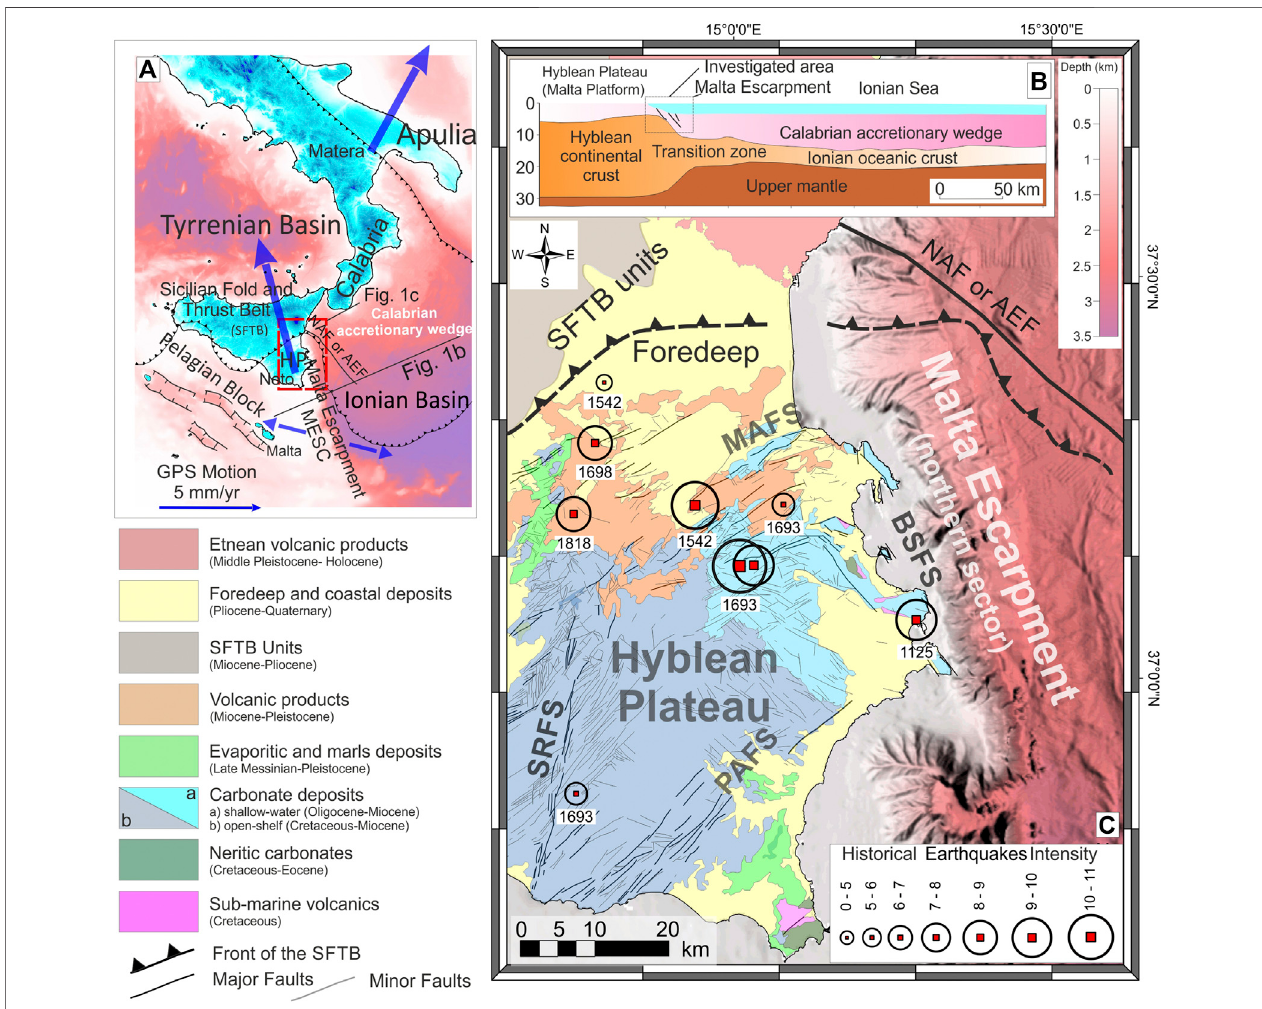
FIGURE 1 | (A) The Malta Escarpment framed in the structural setting of the central Mediterranean region. Large blue arrows indicate diverging geodetic velocities (seeWard1994;Mastrolemboetal.,2014;D ’ AgostinoandSelvaggi,2004;Grenerczyetal.,2005;Palanoetal.,2012)measuredinthelowerplate(HybleanPlateauand ApuliaBlock)ofthecollisionalsystem.ThedivergingmotionresolvesaresultantWNW – ESEextensionalongtheE-Sicily/WesternIonianBasindomain(smallbluearrows) where the inherited NNW – SSE trending Malta Escarpment occurs. (B) Structurally, the investigated area places at the shallow portion of an ancient (Permo – Triassic)ocean – continent transition domain where theMalta Escarpment iswidelyconsidered to bea Mesozoic passivemargin related eitherto E-Wspreading of an Ionian oceanic ridge (see Catalano et al., 2001), or as has been recently suggested atransform margin, related to NE-SW extension (Gallais et al., 2011; Dellong et al., 2018). (C) Structural setting of the Malta Escarpment footwall block, the SE Sicily. Black circles indicate the epicentres of the most energetic historical earthquakes occurred in the area. Acronyms are as follows: SRFS, Scicli – Ragusa Faults System; PAFS, Pozzallo – Avola Faults System; MAFS, Monterosso – Agnone Faults System; BSFS, Brucoli – Siracusa Faults Systems; NAF of AEF, North Alfeo Fault or Alfeo Etna Fault (Gutscher et al., 2016; Polonia et al.,